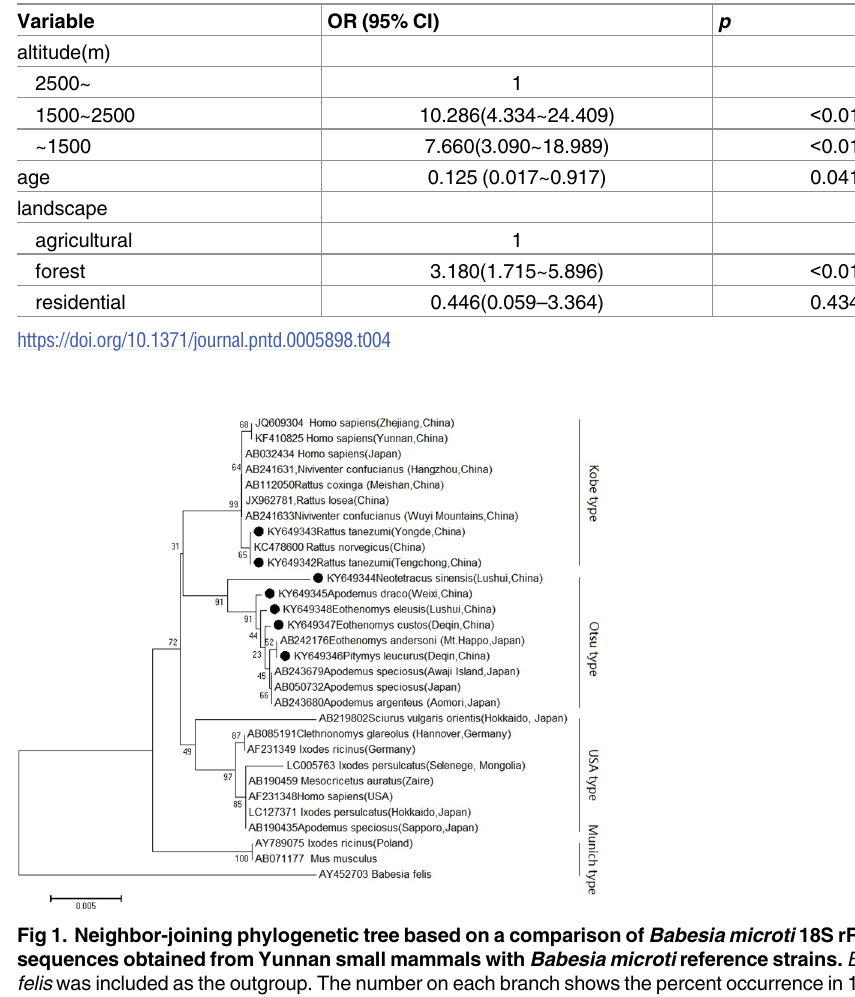
Table 4. Risk factors related to B . microti based on multivariate logistic regression.